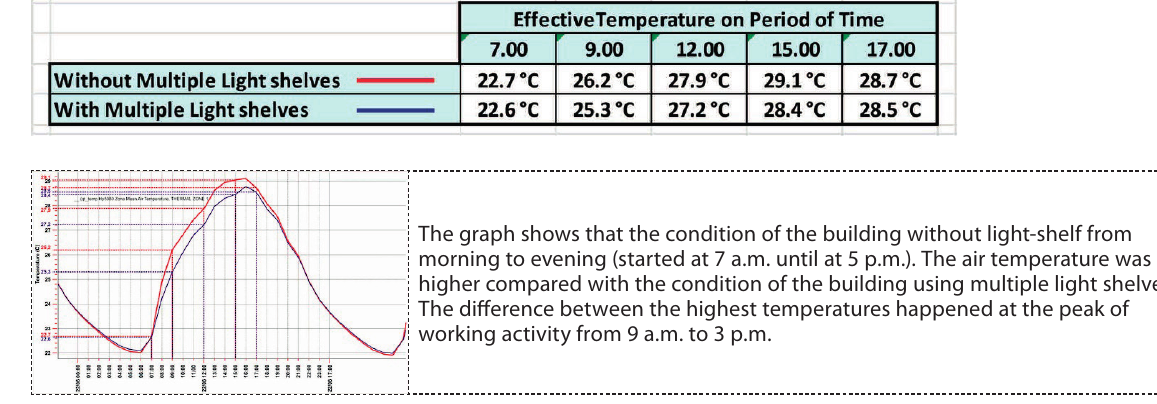
Fig. 16. The graph of the average air effective temperature